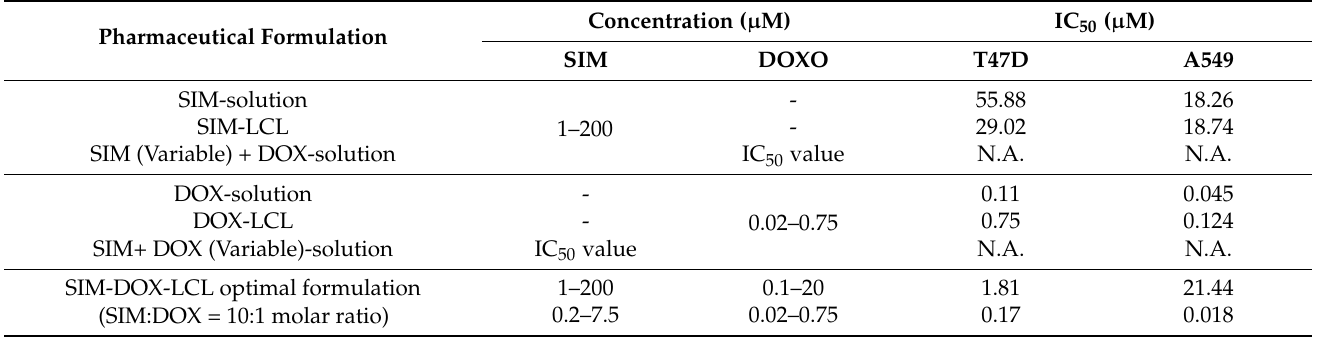
Table 6. The IC 50 values of SIM and